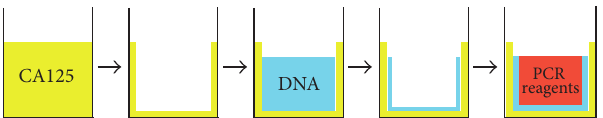
Figure 2: Schematic representation of One-Pot SELEX. All steps occur in a single PCR tube. First the protein target (CA125) is allowed to adsorb to the inner surface of the tube. Multiple rinsing steps remove all proteins that are not strongly adsorbed. Then ssDNA—either unselected library or DNA selected in the previous SELEX round—is added and allowed to equilibrate with adsorbed protein. Vigorous rinsing retains only those DNA molecules that bind the protein target with high affinity. These DNA sequences are amplified via PCR in the final